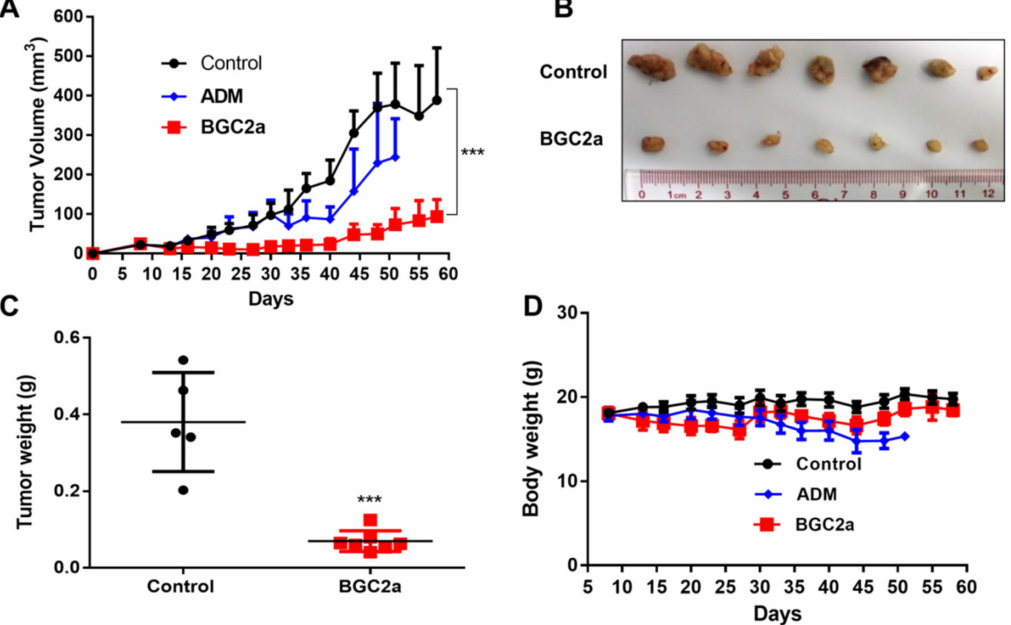
Figure 5. The inhibition of tumor growth in lung cancer A549 cells xenograft mouse model by BGC2a. ( A ) The measured tumor volumes. (***) p < 0.001 vs. the control group. ( B ) The tumors after the sacrifice of mice. ( C ) Quantification of the tumor weights from ( B ). (***) p < 0.001 vs. the control group. ( D ) Body weights of the treated mice. Mouse weight was measured 2 times a